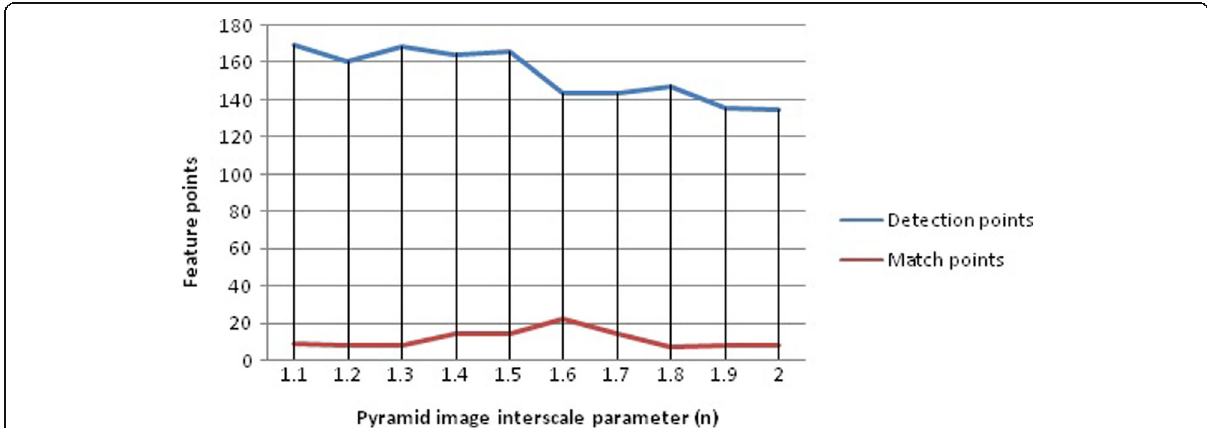
Fig. 21 Comparison of the number of feature points detected and the number of exact matches when the scale parameters of the pyramid image change